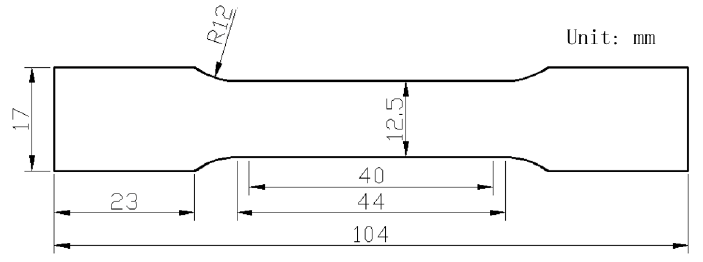
Figure 2. The dimensions of tensile samples.